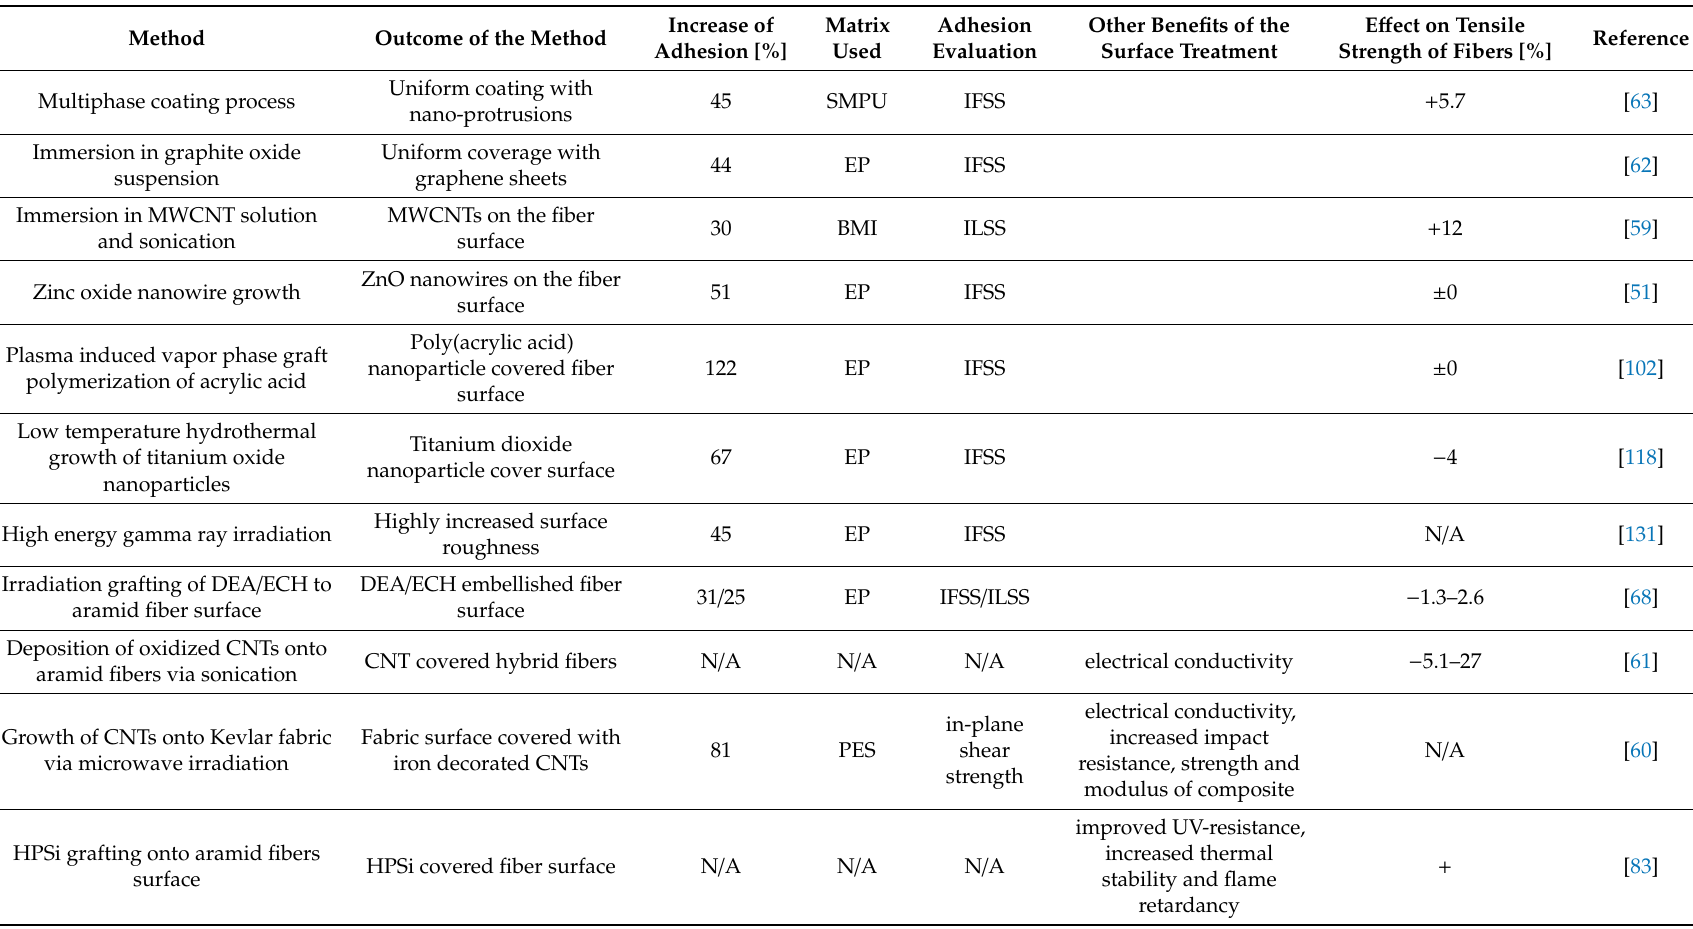
Table A1. A summary of the methods to improve adhesion of aramid fibers by introducing hierarchical structures to the fiber surface as well as their key benefits and